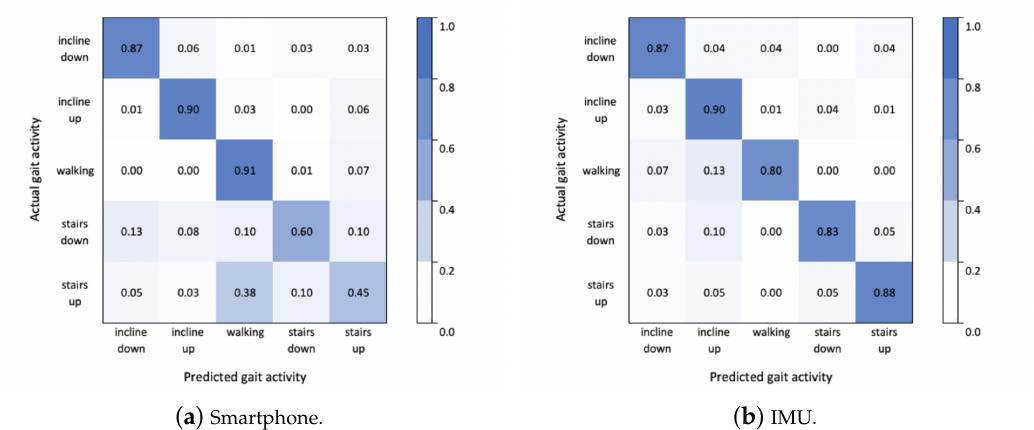
Figure 5. Confusion matrices for KNN classifiers built using the data treatment acc FD + acc XYZ from smartphone ( a ) and IMU ( b